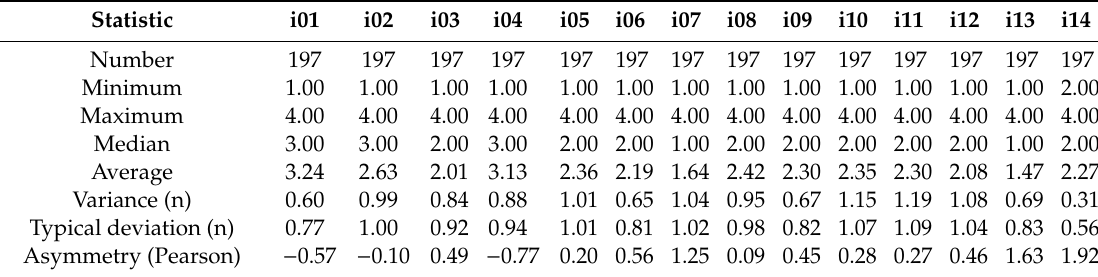
Table 6. Statistics of the items which make up the Q-Edutage scale.